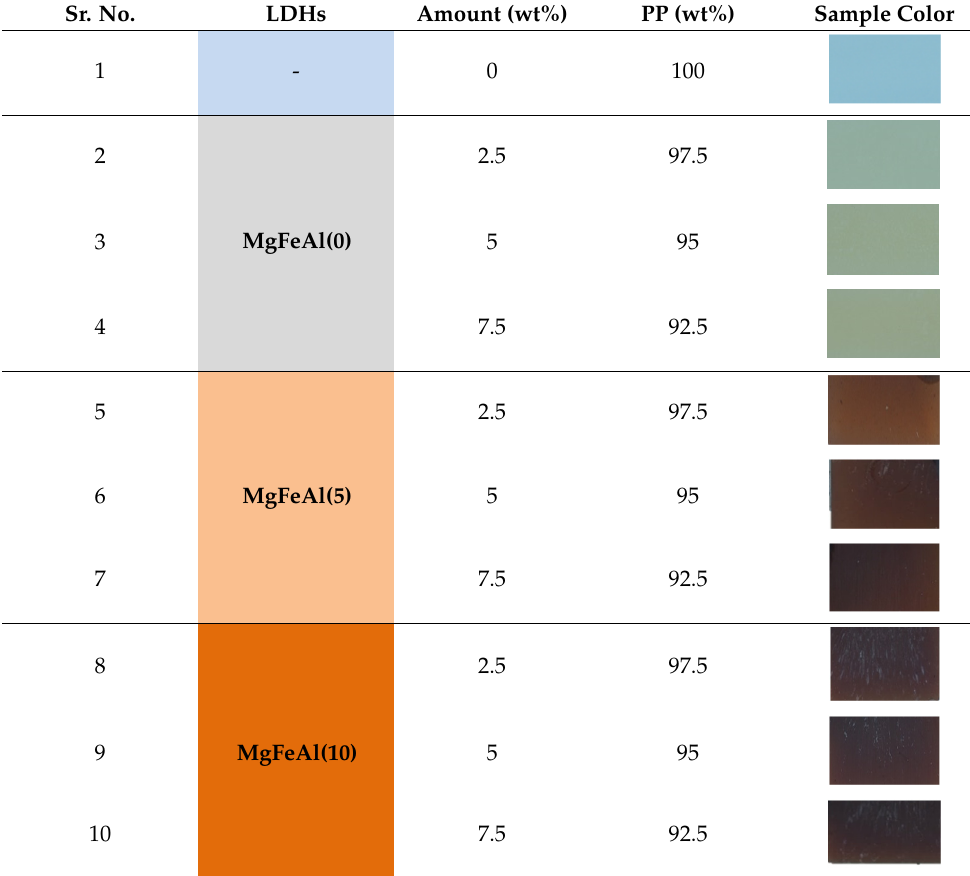
Table 1. Sample details of LDH/PP nanocomposites with their pictures. Sr. No.